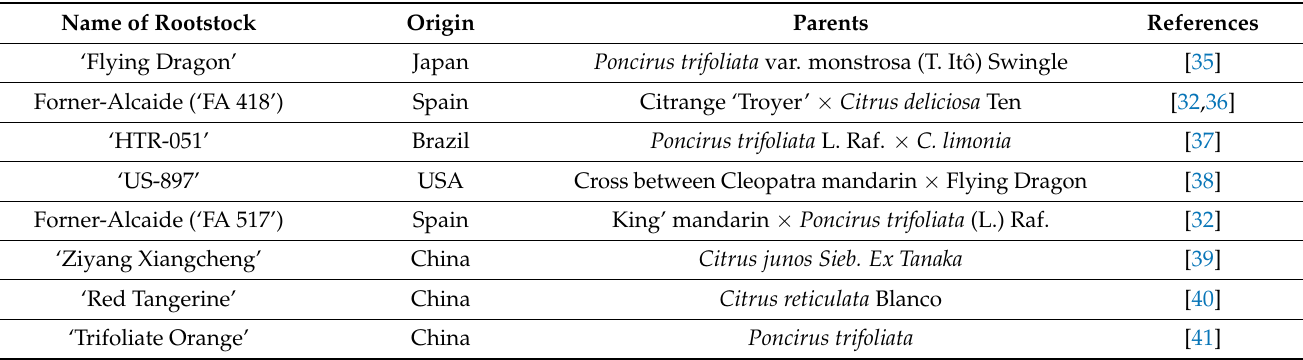
Table 1. Main dwarfing citrus rootstocks are used